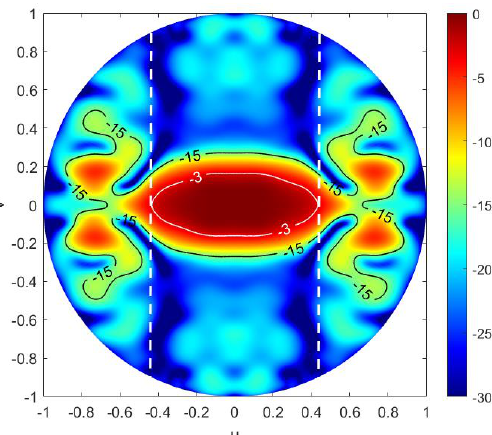
Figure 8. Embedded element pattern of the optimized sub-array at the center of the 11 × 5 array, displayed in the uv-plane, where u = sinθcosφ and v = sinθsinφ. The black and white solid lines encircle areas with a level higher than −15 dB and −3 dB compared to the maximum value. All presented results are obtained at the design frequency f 0 = 28.0 GHz.